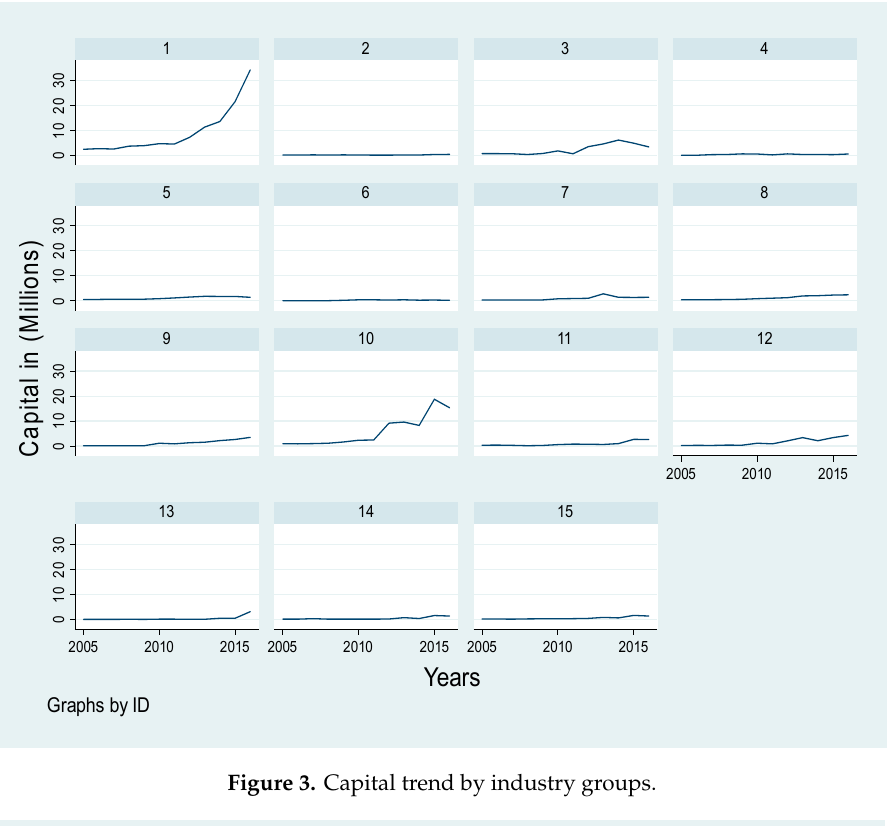
Figure 3. Capital trend by industry groups.